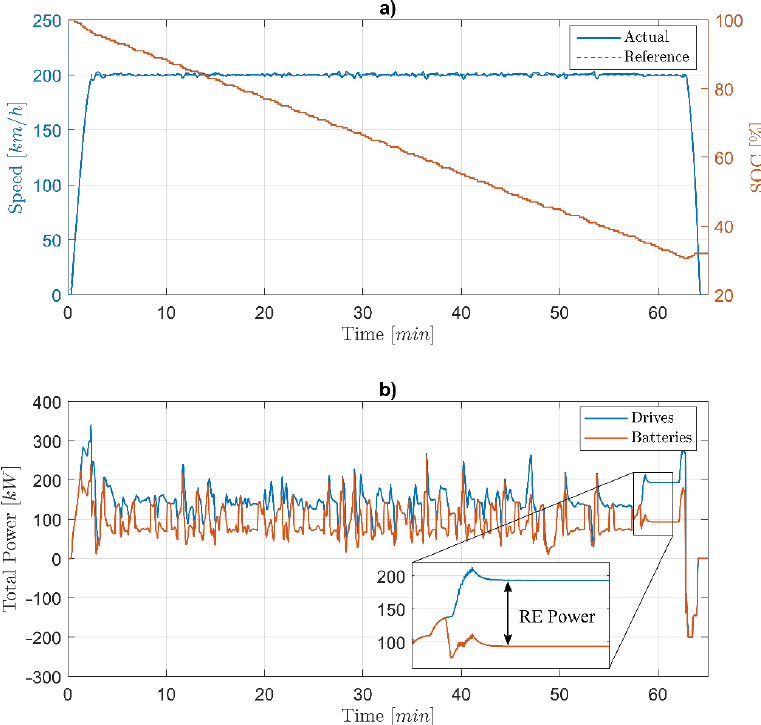
Figure 12. Simulation results of the first scenario in terms of the speed of the vehicle and SOC ( a ) and the total power of the motor drives and total power of the batteries ( b ).